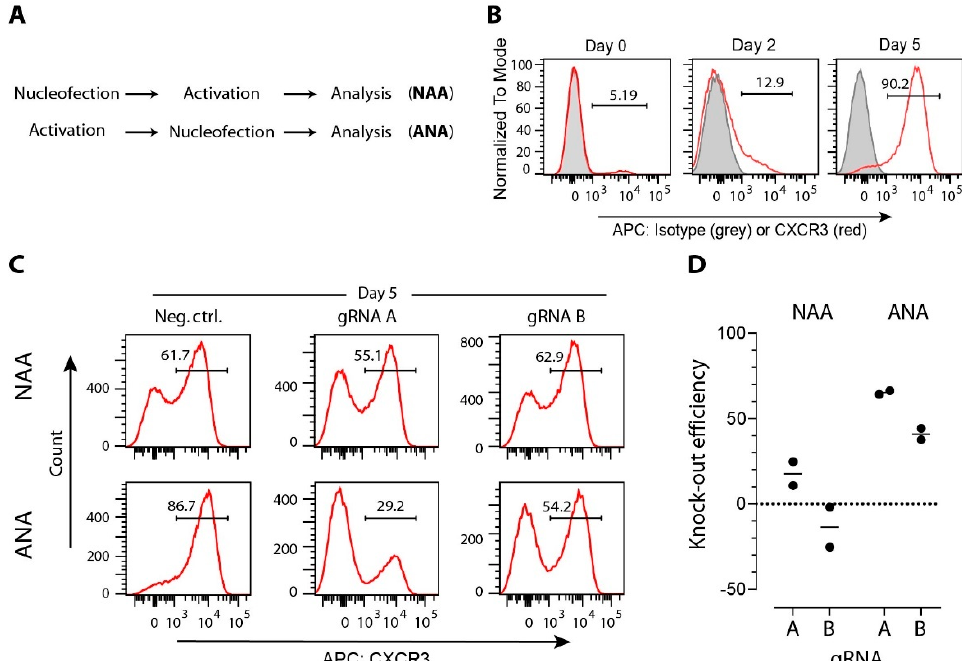
Figure 2. Efficacy of CRISPR/Cas9-induced modifications in T cells is affected by gene expression level. ( A ) CD4+ T cells and MACS-sorted from mice spleen and lymph nodes, were either immediately nucleofected before activation (protocol NAA) or were first activated and then nucleofected (protocol ANA). T-cell activation on anti-CD3/-CD28 coated wells, nucleofection with one two anti- Cxcr3 crRNAs (A: 5 ′ -TGACTCCCCGCCCTGCCCAC-3 ′ ; B: 5 ′ -GCTGTTCTGCTGGTCTCCAG-3 ′ ) or with a negative control crRNA (Neg Ctrl: 5 ′ -CGTTAATCGCGTATAATACG-3 ′ ) coupled with tracrRNA and Cas9 (all components from Integrated DNA Technologies Inc.) into CRISPR/Cas9 ribonucleoproteins (RNPs), and expansion in medium supplemented with 100 U/mL of interleukin-2 was performed according to our previously published protocol [99]. ( B ) Representative histogram plots showing CXCR3 expression on CD3 + CD4 + T cells immediately after isolation (day 0), after anti-CD3/-CD28 activation (day 2), or after additional 3 days of expansion (day 5). ( C ) Representative histogram plots showing CXCR3 expression on CD3 + CD4 + T cells nucleofected with indicated Cas9 RNPs. ( D ) Gene-editing efficacy expressed as a relative decrease of CD3 + CD4 + CXCR3+ cells after nucleofection anti- Cxcr3 crRNAs compared to negative control group. Data are from two independent experiments (dots), and group means are shown as lines.